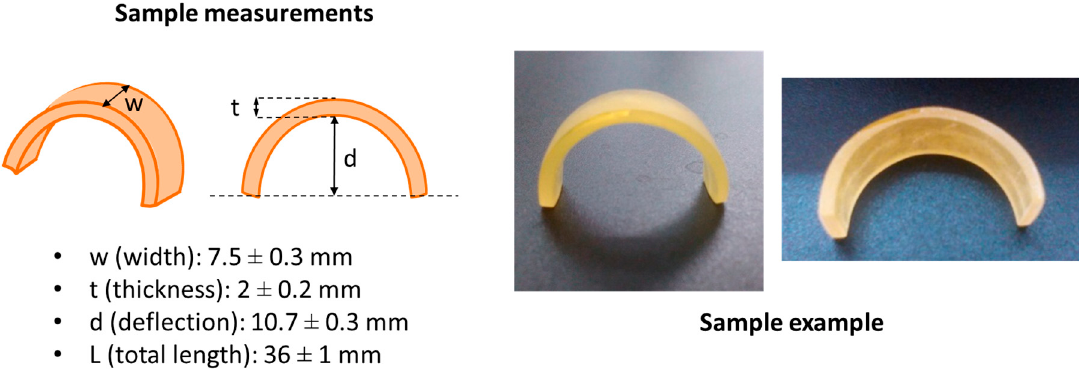
Figure 2. Bent-shaped sample measuring definitions and a photograph of the final sample.